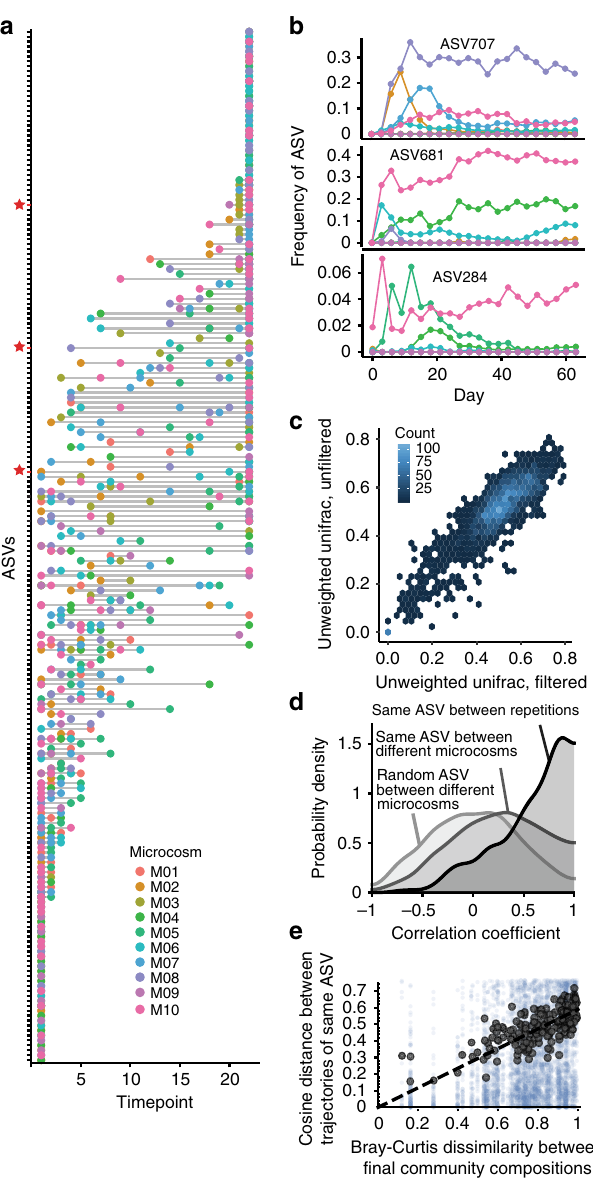
Fig. 3 Species dynamics are context dependent. a The y -axis lists all ASVs shared by at least two microcosms. Colored points mark which day the ASV was lost from that particular microcosm. Points at the far right of the graph are ASVs that persisted to the end of the serial transfer experiment. Red stars mark the ASVs shown in b . b Three examples of ASV dynamics in the different microcosms over time, where ASVs were lost early in some microcosms but persisted until the end in others. c Unweighted UniFrac distances in fi ltered and un fi ltered communities (repetitions) are strongly correlated, highlighting that community dynamics are reproducible given the same inoculum. Mantel test, r = 0.85, p = 1×10 − 4 ; Linear model, R 2 = 0.78, p = 2.2×10 − 16 . Samples from Days 0 – 21 are included here, to capture dynamics up until equilibration. Hexplot color indicates the density of values in each hexagon. d Probability density of correlation coef fi cients between the same ASVs in repetitions started from the same inocula, between the same ASVs in distinct microcosms, and between randomly chosen ASVs. Correlation coef fi cients are large when comparing replicate communities started from the same pitcher plant inocula. Between different microcosms, there is a moderate increase in the number of positive correlation coef fi cients relative to random